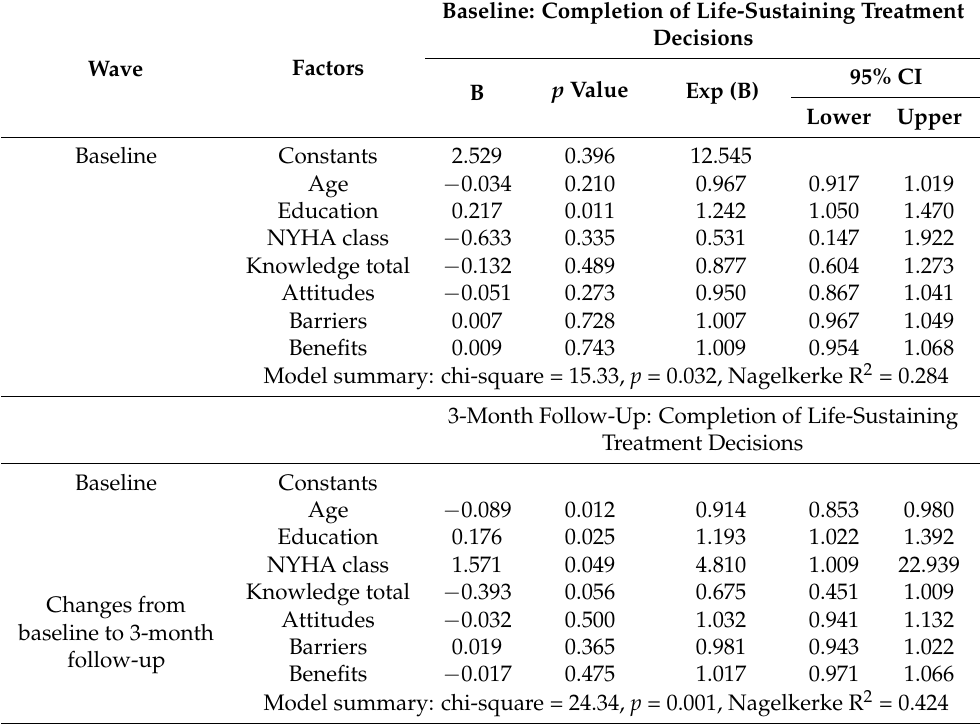
Baseline: Completion of Life-Sustaining Treatment Decisions 95% CI B p Value Exp (B) Lower